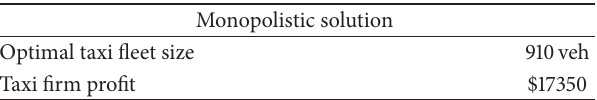
Figure 4: The profits of taxi firms for the oligopoly market as taxi fleet size varied. Table 3: The monopolistic solution when vacant taxis are exempted from tolling.